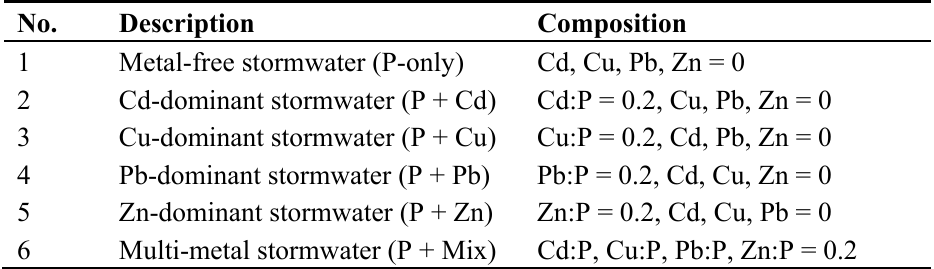
Table 2. Composition of the six synthetic stormwater solutions (M:P =